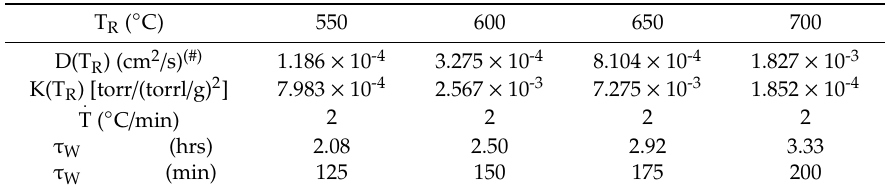
Table 6. Di ff usivity *, Sieverts’ constant and warm up τ W of ZAO for di ff erent values of the regeneration temperature T R .